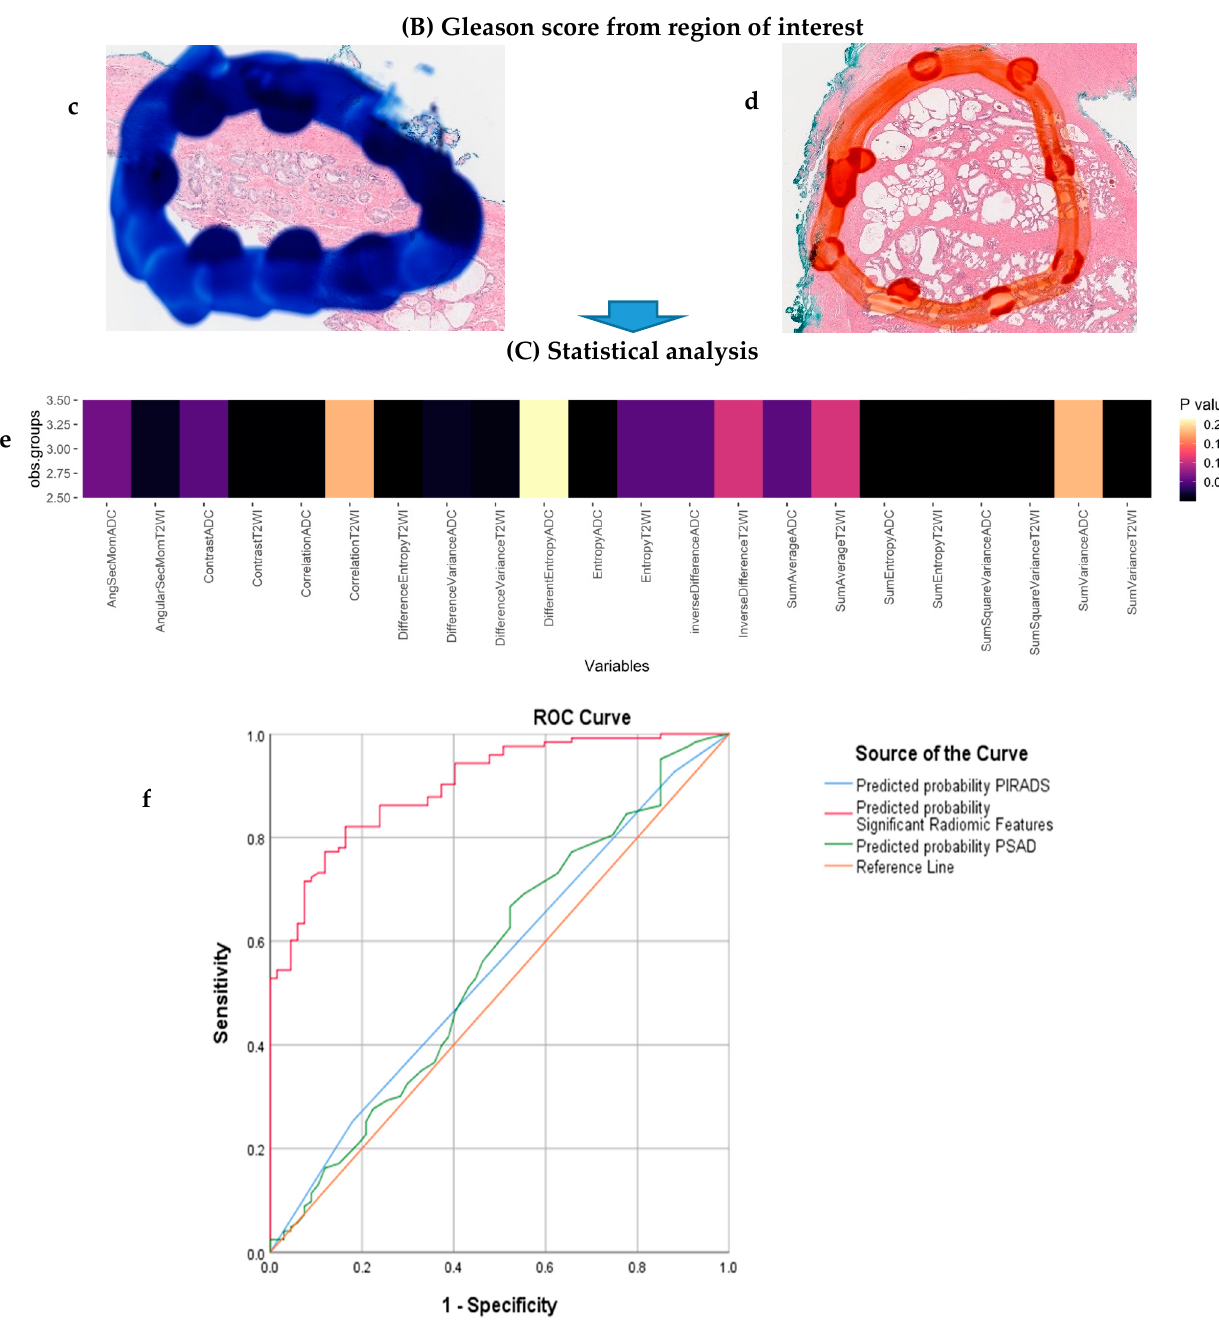
Figure 1. Research workflow. ( A ) mpMR images showing the segmented region of interest (ROI) marked red in both the T2WI and ADC images for extraction of quantitative imaging texture features ( a , b ). ( B ) Microscopic view of clinically significant prostate cancer on histological grading (Gleason’s score) ( c , d ). ( C ) Correlation showing significance analysis and AUC obtained by the linear regression models for predicting radiomic features with PIRADS: ( e ) Heatmap of the Kruskal–Wallis (after applying the Holm–Bonferroni correction) significant test p -values using radiomics features to identify patients of different GS. Significant features that were compared with the GS groups are shown in the colour black (corrected p -value < 0.05). ( f ) Receiver operating characteristics (ROC) curve and area under the curve (AUC) for model discriminative ability (the areas under the ROC are 0.551 for PIRADS, 0.901 for significant RF and 0.557 for PSAD).